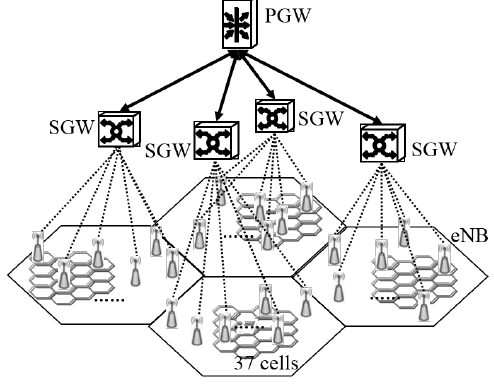
Figure 4: Simulation